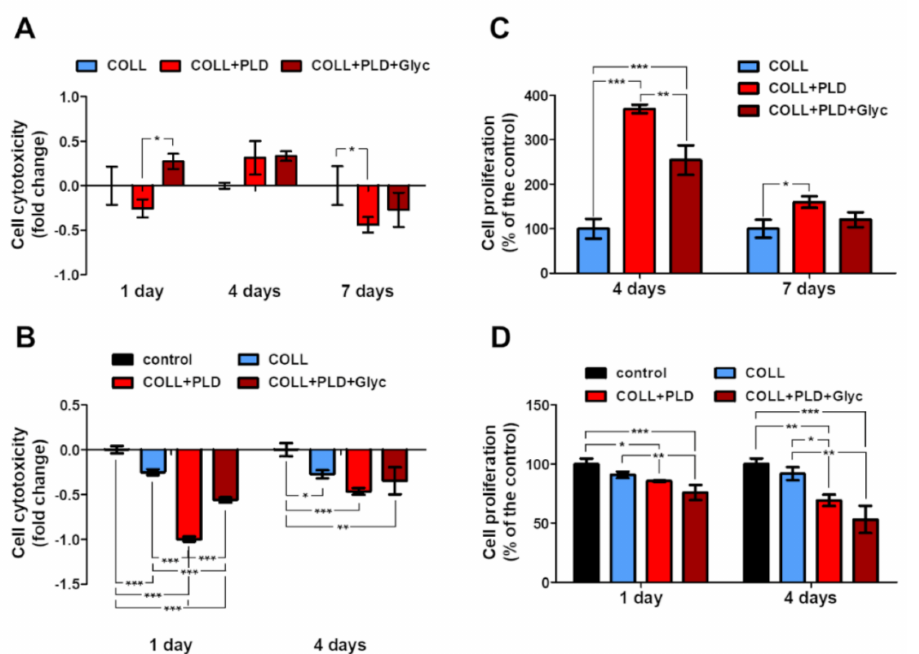
Figure 4. Effect of the prostheses on HUVEC cells: ( A , B ) prosthesis cytotoxicity evaluated with LDH assay towards cells grown on them for 1, 4 and 7 days (direct test; A ) and cytotoxicity of the extracts (indirect test; B ); ( C , D ) proliferation of the cells grown on the biomaterials (direct test; C ) and incubated with the prosthesis extracts (indirect test, D ); statistical significance was indicated with (*) symbol; *— p < 0.05, **— p < 0.01, ***— p < 0.001, one-way ANOVA, Tukey’s post hoc